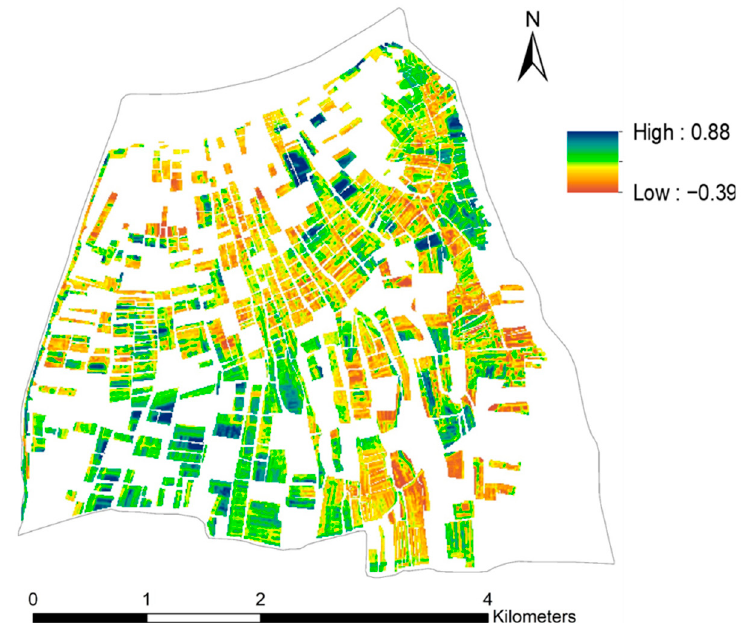
Figure 3. Map of NDVI in the mangrove-fish pond areas.